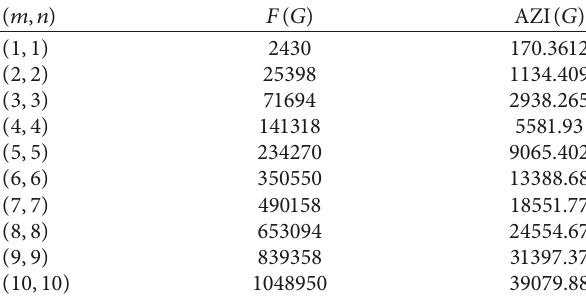
Table 4: Connection between F and AZI.